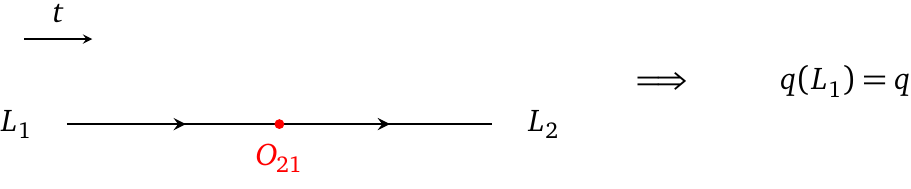
Figure 1: Consider two line defects L and L such that there exists a junction local 1 2 (cid:54) = 0 between them. Then, we can construct a configuration as shown operator O 21 on the left side of figure with time flowing horizontally. For charge conservation, the ) and q ( L ) of L charges q ( L and L must 1 2 1 2